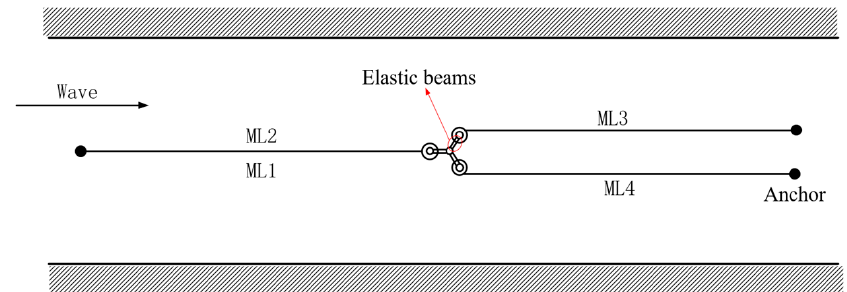
Figure 6. Configuration of the platform and mooring lines in the water tank test. Table 4. Environmental conditions of the tests.